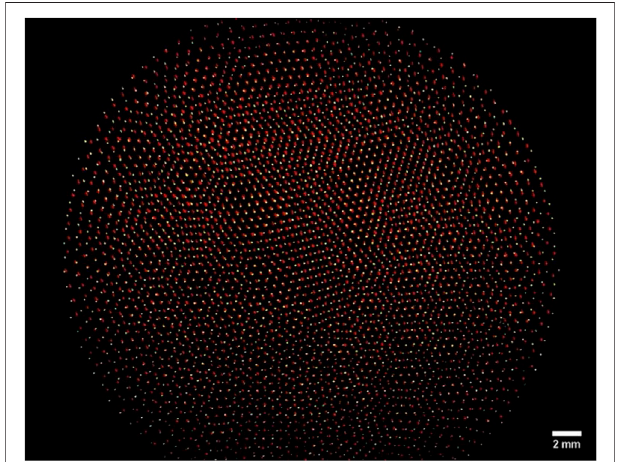
FIGURE 6 | Superimposed image of two top-view images of the dust crystalrecordedatheightsof13.9 mm(red)and0.9 mm(yellow),withplasma power on and off, respectively. These images were recorded about 1 min apart; during the time interval between we moved the horizontal laser sheet and top-view camera downward to record the image at 0.9 mm.